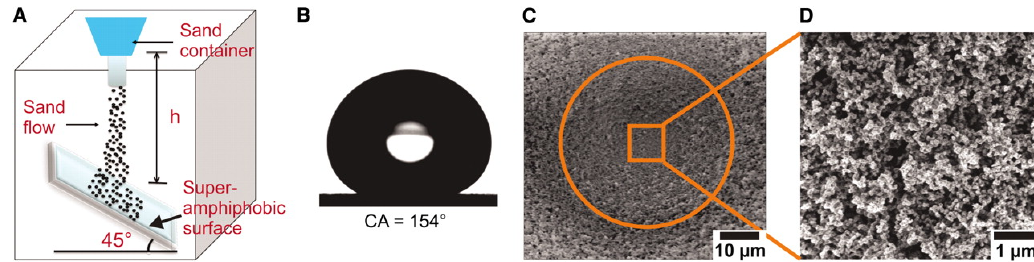
Figure 10. Mechanical resistance quantified by sand abrasion. ( A ) Schematic drawing of a sand abrasion experiment; ( B ) Hexadecane drop deposited on the coating after 20 g of sand abrasion from 40 cm height. The 100 ‐ to 300 ‐μ m ‐ sized grains had a velocity of 11 km/hour just before impingement. After impingement, the drops rolled off after the substrate was tilted by 5°; ( C ) SEM image of a spherical crater (orange circle) after sand abrasion; ( D ) SEM image of the surface topography inside the cavity [36].